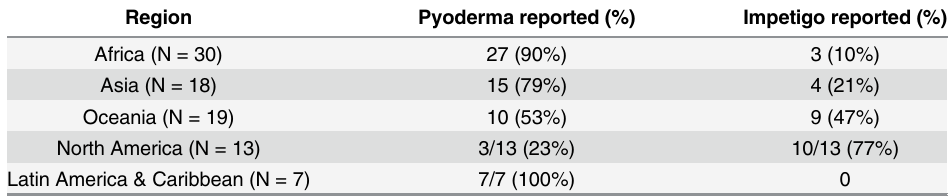
Table 7. Regional variation in the use of pyoderma or impetigo to describe bacterial skin infections.